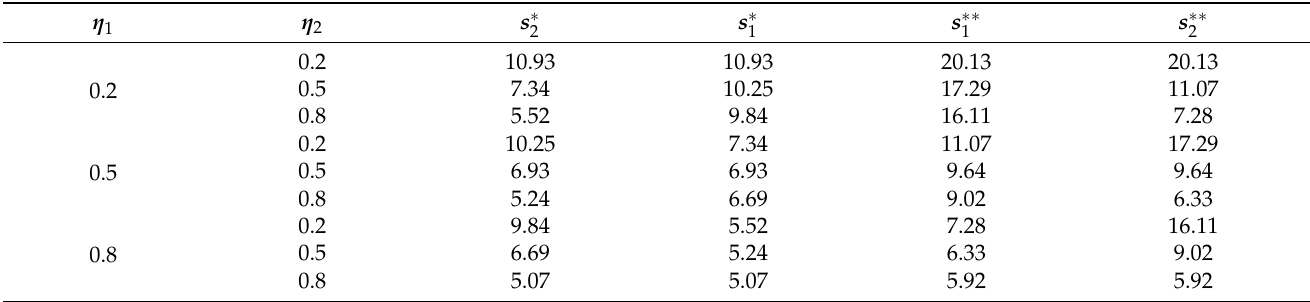
Table 3. Effort level changes with the degree of risk aversion.